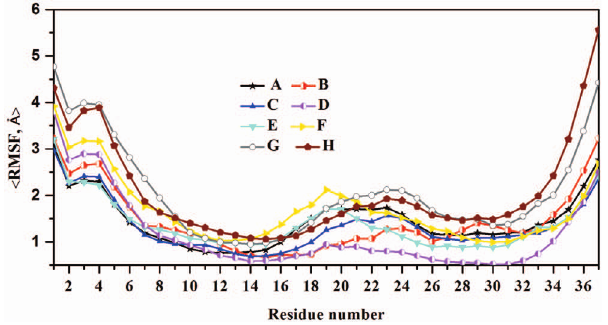
Figure 4. Root-mean-square fluctuation (RMSF) of the C a atoms calculated from the three molecular dynamics simula- tions. A) Single layer conformation of human amylin, (B) single layer conformation of rat amylin, (C) single layer conformation of human-rat complex, (D) Double layer conformation of human amylin with CC interface (E) Double layer conformation of rat amylin with CC interface, (F) Double layer conformation of rat and human amylin mixtures with CC interface, (G) Double layer conformation of rat amylin with NN interface and (H) Double layer conformation of rat–human amylin complex with NN